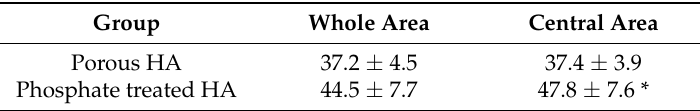
Table 2. The bone formation